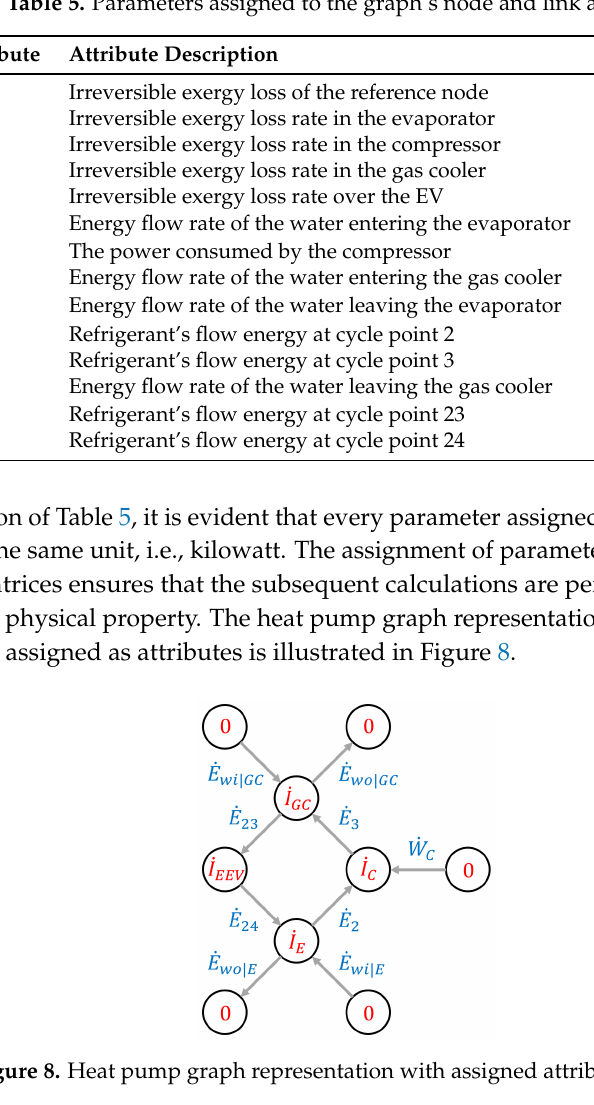
Table 5. Parameters assigned to the graph’s node and link attributes.